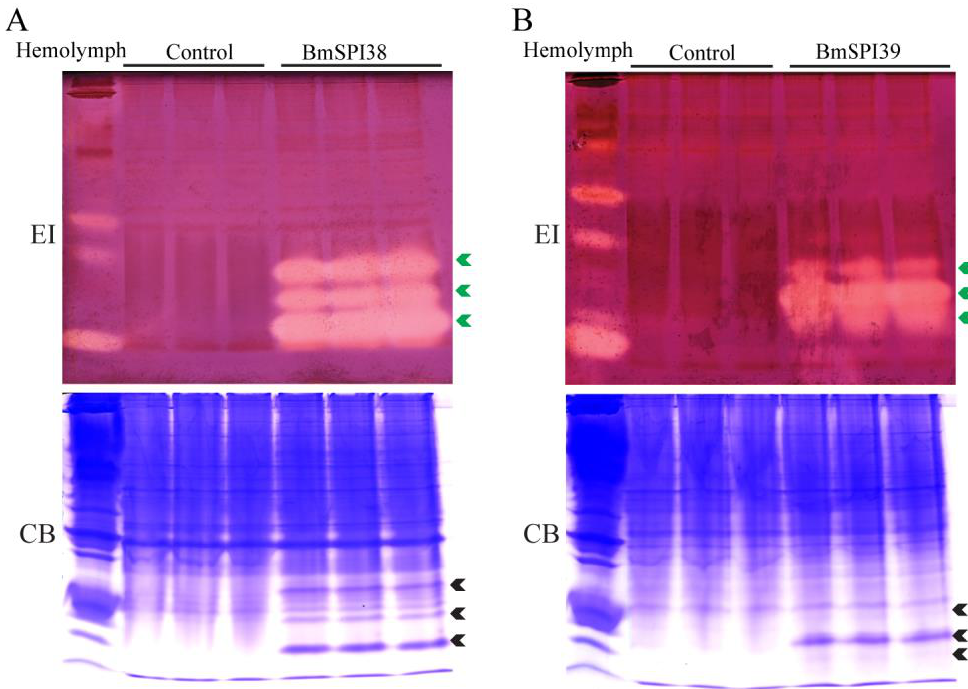
Figure 1. BmSPI38 and BmSPI39 have elastase inhibitory activity. Activity staining of recombinantly expressed BmSPI38 ( A ) and BmSPI39 ( B ) against elastase. The soluble E. coli extracts containing the recombinant BmSPI38 or BmSPI39 were separated with 10% Native PAGE and visualized by in-gel activity staining against elastase. B. mori hemolymph from day 5 fifth-instar larvae was used as positive control. “Control” represents the lysate supernatant of Origami 2(DE3) or BL21(DE3) cells transformed with the p28 plasmid. “EI” indicates inhibitory activity against elastase, and “CB” indicates protein staining with Coomassie Brilliant Blue R250. Green arrows indicate the active bands of the protease inhibitors, and black arrows indicate the Coomassie Brilliant Blue-stained protein bands at the position corresponding to the inhibitory-active bands.